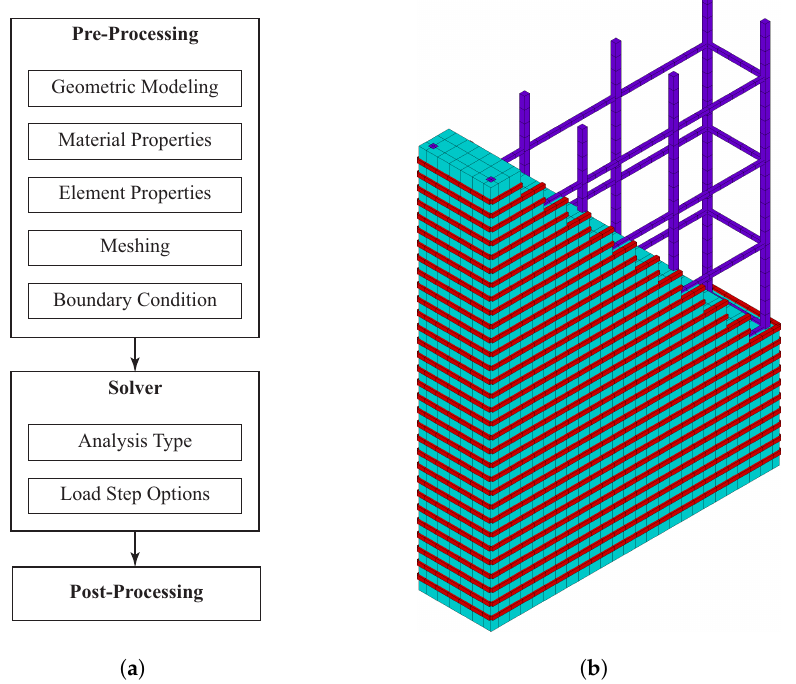
Figure 3. Numerical methodology flow-chart ( a ) and column II4 modeled in ANSYS ( b ).